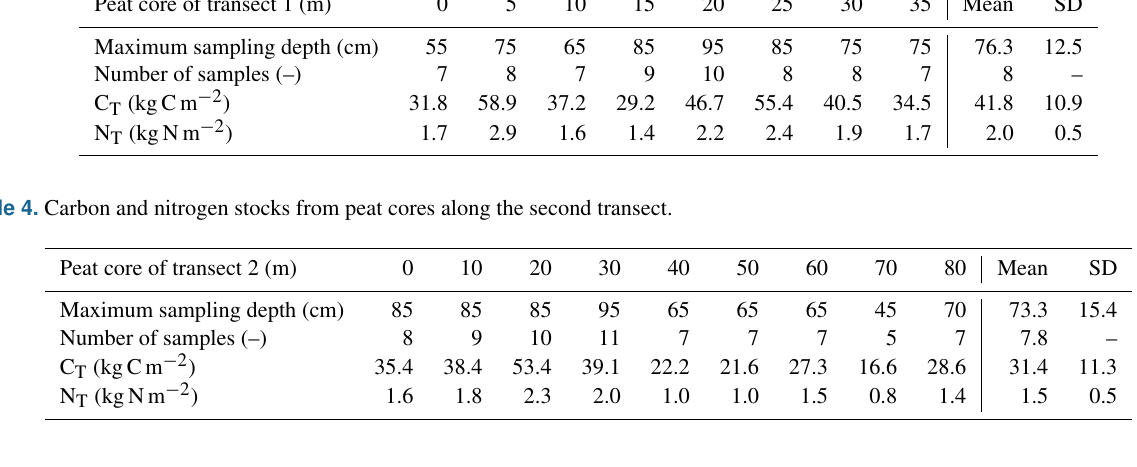
Table 3. Carbon and nitrogen stocks from peat cores along the first transect. Peat core of transect 1 (m) 0 Maximum sampling depth (cm) Number of samples (–)